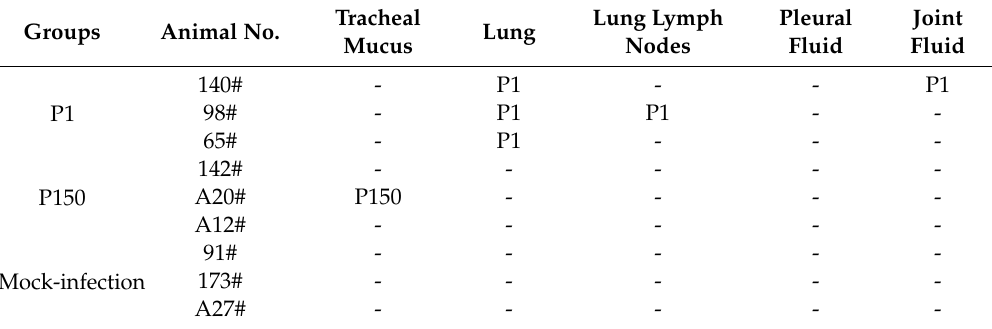
Table 2. Isolation of M. bovis from the samples of experimental calves at the end of observation period (60 days